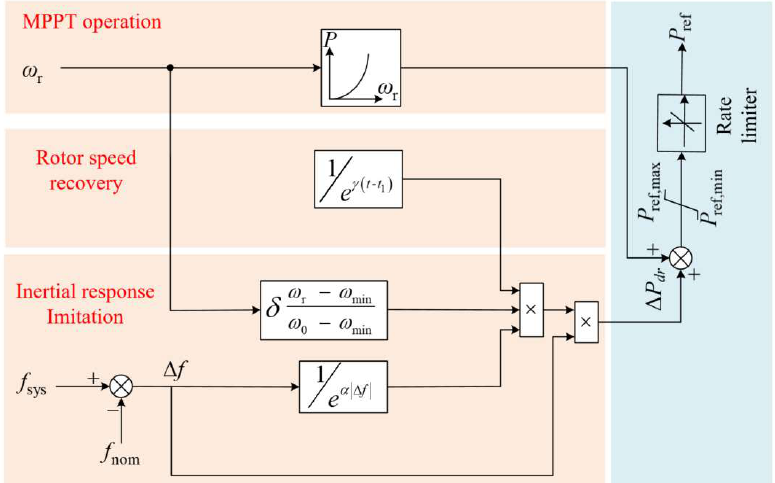
Figure 6. Structure of conventional scheme #2.